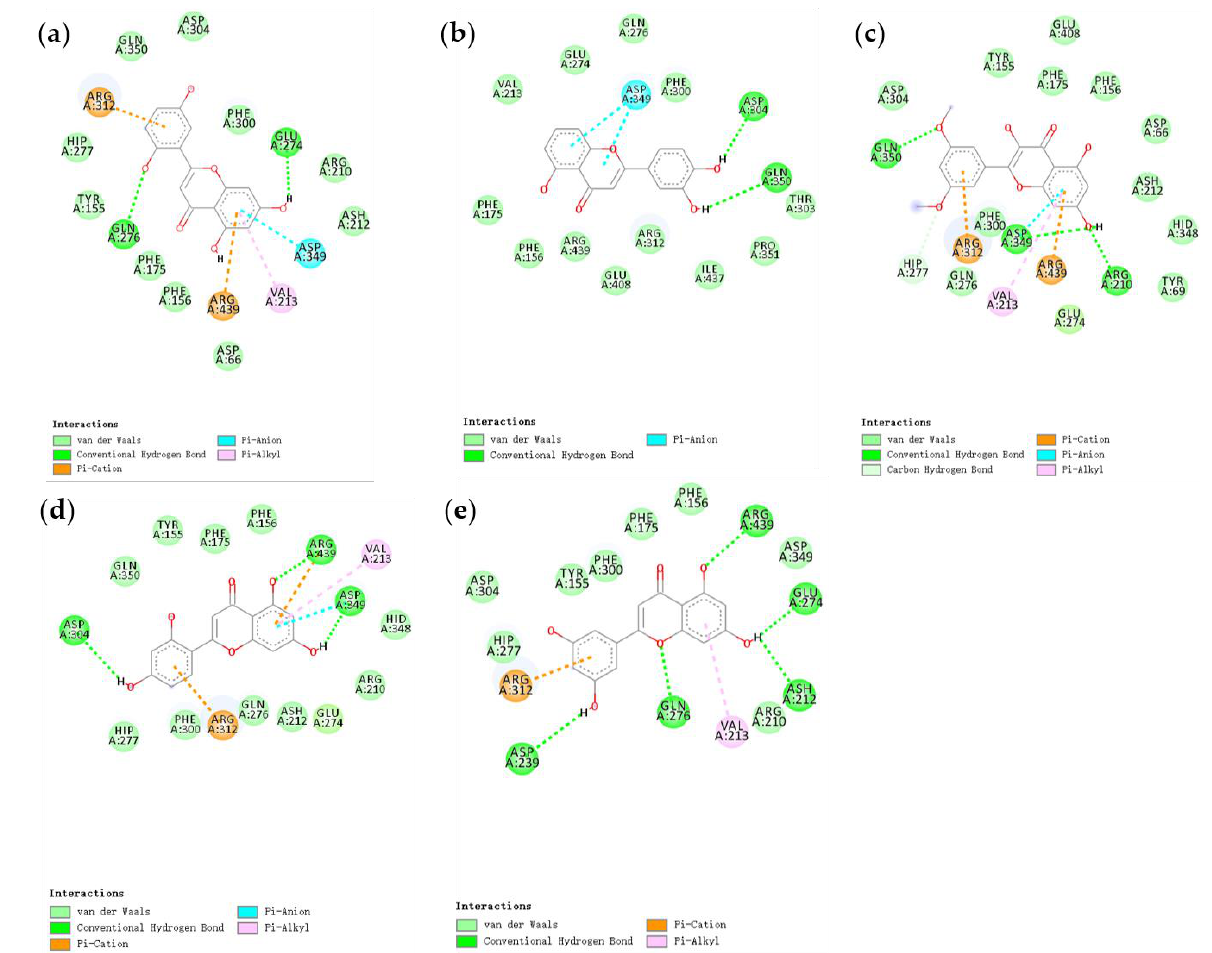
Figure 4. Docking interactions between five novel natural products and α -glucosidase 3A4A: ( a ) 2-(2,5-dihydroxyphenyl)-5,7-dihydroxy-4H-chromen-4-one; ( b ) 2-(3,4-dihydroxyphenyl)-5-hydroxy-4H-chromen-4-one; ( c ) morelosin; ( d ) norartocarpetin; ( e ) 2-(3,5-dihydroxyphenyl)-5,7-dihydroxy-4H-chromen-4-one.